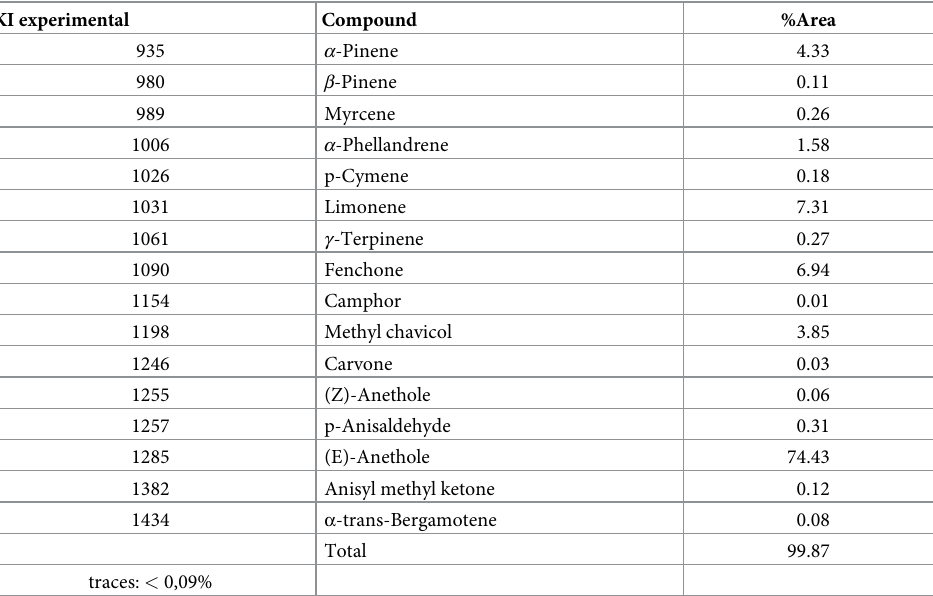
Table 1. GC-Mass of fennel essential oil.